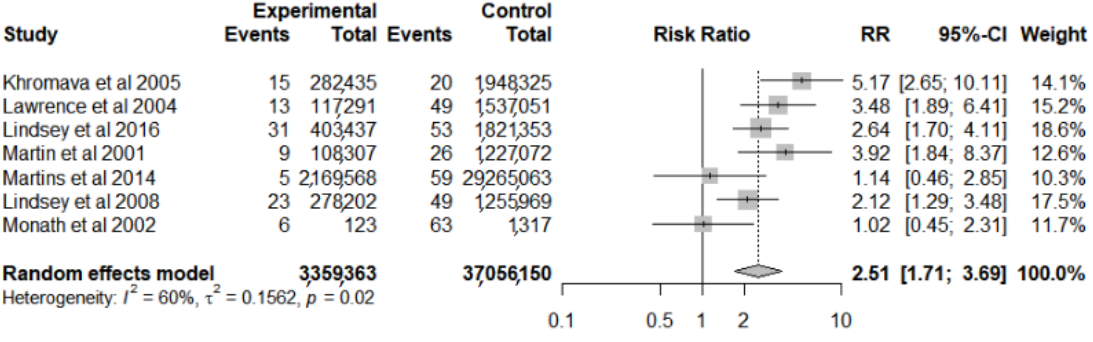
Figure 3. Forest plot of risk factor meta-analysis for serious adverse events after yellow fever vaccine use in the elderly.